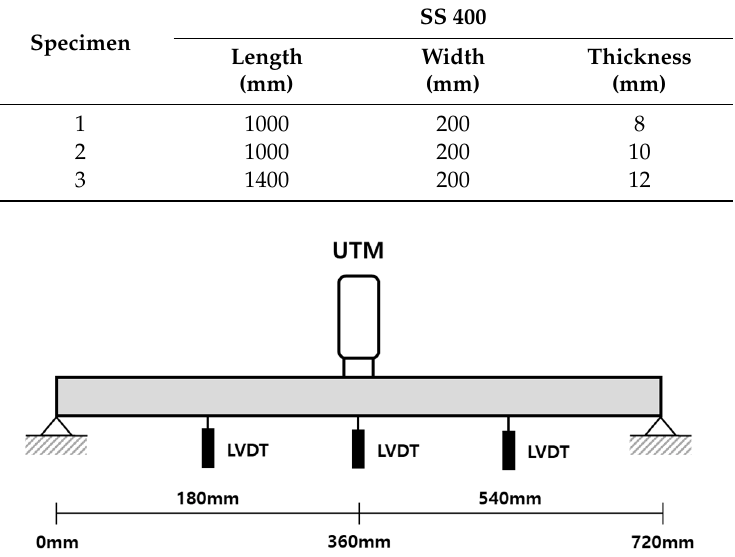
Table 2. Details of SS400 specimen used in the experiment.